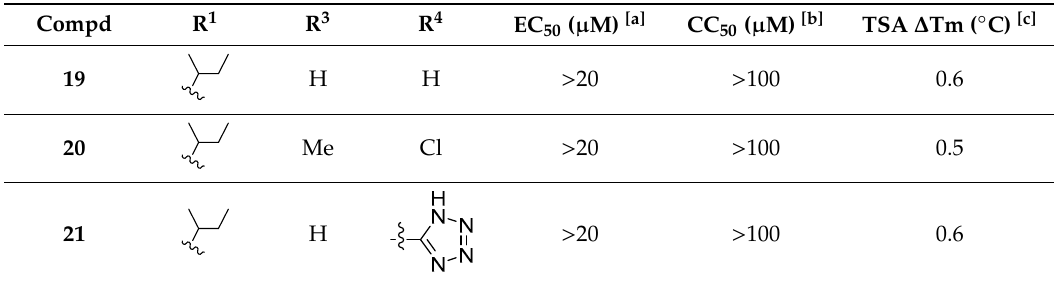
deviation from at least two independent experiments. b Concentration of compound causing 50% cell